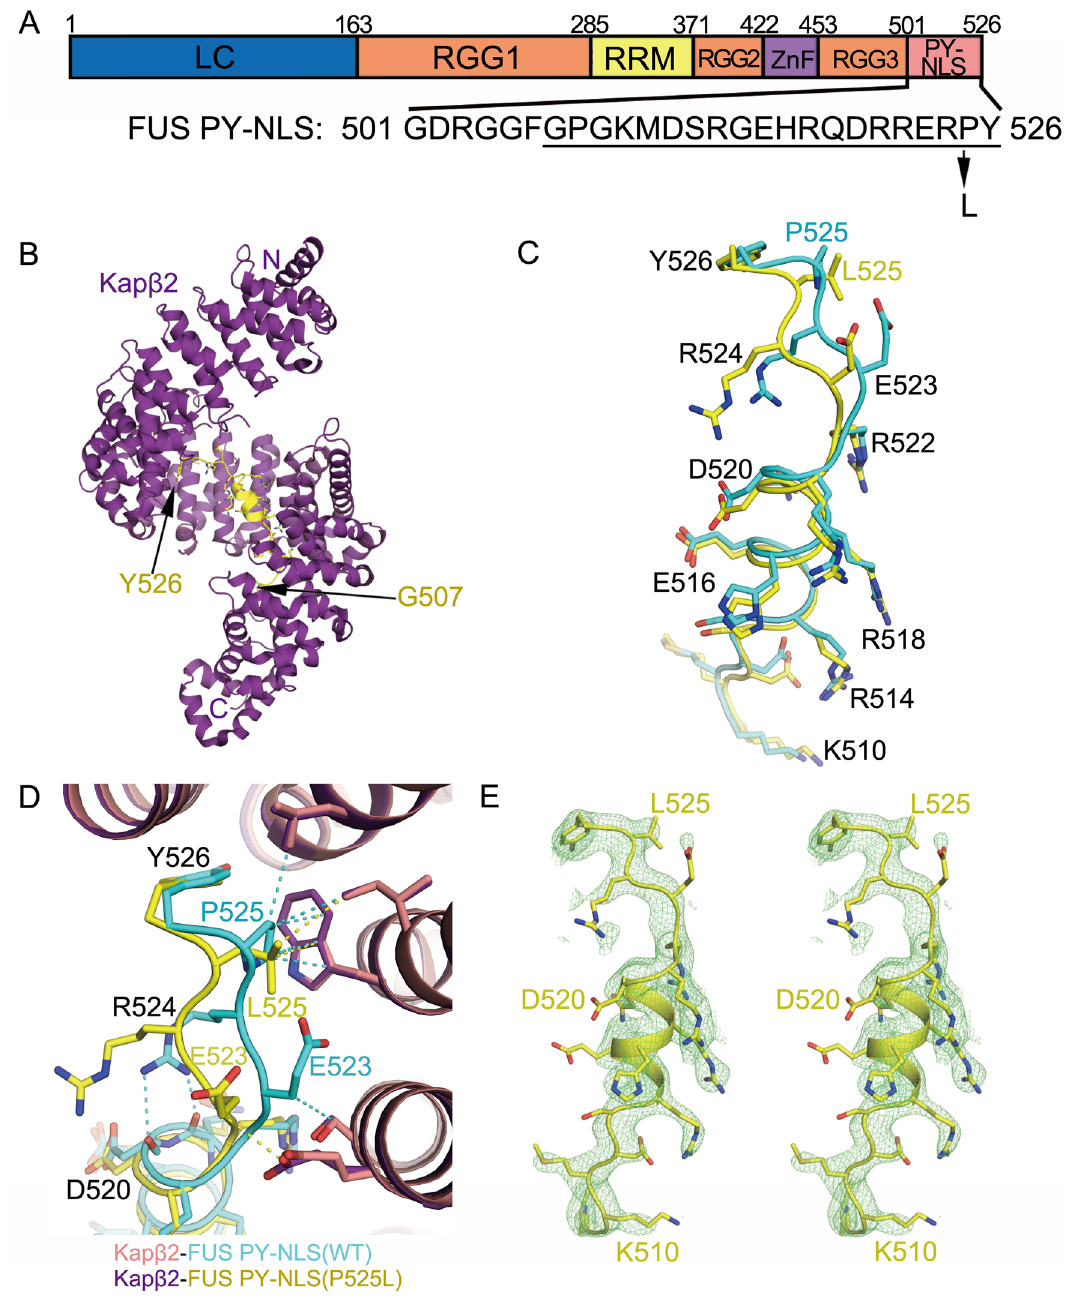
Figure 1. Structure of Kapβ2·FUS(P525L) PY-NLS complex. ( A ) Sequence of FUS PY-NLS and the P525L mutation site. PY-NLS residues that are modeled in the Kapβ2·FUS(P525L) PY-NLS crystal structure are underlined. ( B ) The overall structure of FUS(P525L) PY-NLS (yellow) bound to Kapβ2 (purple). ( C ) Comparison of the Kapβ2-bound FUS(P525L) PY-NLS (yellow) with WT FUS PY-NLS (cyan). ( D ) Details of PY-NLS epitope-3 (FUS(P525L) PY-NLS is in yellow; WT FUS PY-NLS in cyan) interacting with Kapβ2 (purple and pink). Representative contacts ≤ 4.1 Å are shown as dashed lines. ( E ) Stereo view of the simulated annealing (SA) composite omit map 2Fo—Fc map contoured at 1.0σ overlaid onto the modeled mutant PY-NLS Although the R495X mutation causes the nuclear protein FUS to accumulate in the cytoplasm, imaging studies of mammalian cells transfected with FUS(R495X) show that a fraction of the protein remains in the nucleus. Similarly, a small fraction FUS(P525L) localizes to the nucleus even though the protein is substan- tially mislocalized to the cytoplasm. It is unclear how the P525L missense mutation affects interactions of the PY-NLS with Kapβ2. It is also not known how FUS(R495X) is transported into the nucleus when it is missing the PY-NLS. Does it still bind Kapβ2 and be imported by this importin or does it bind other importins like the